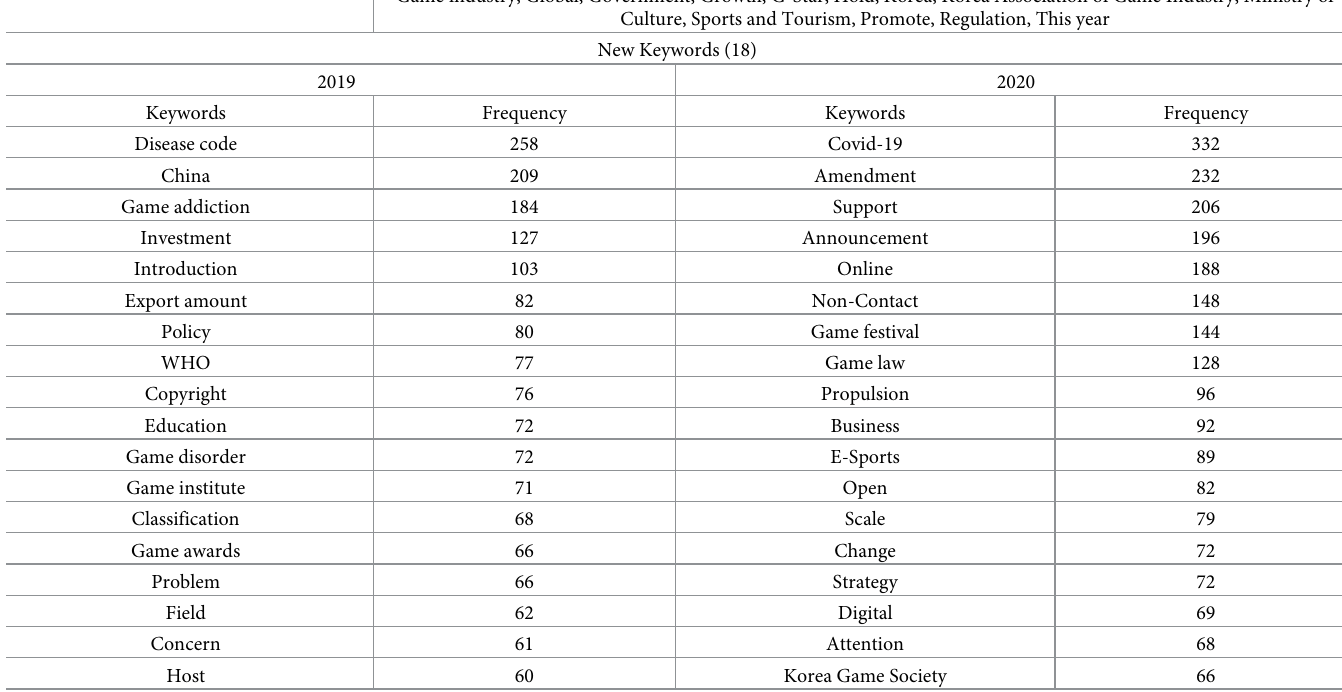
Table 6. Game industry keywords comparison between 2019 and 2020. Repeated